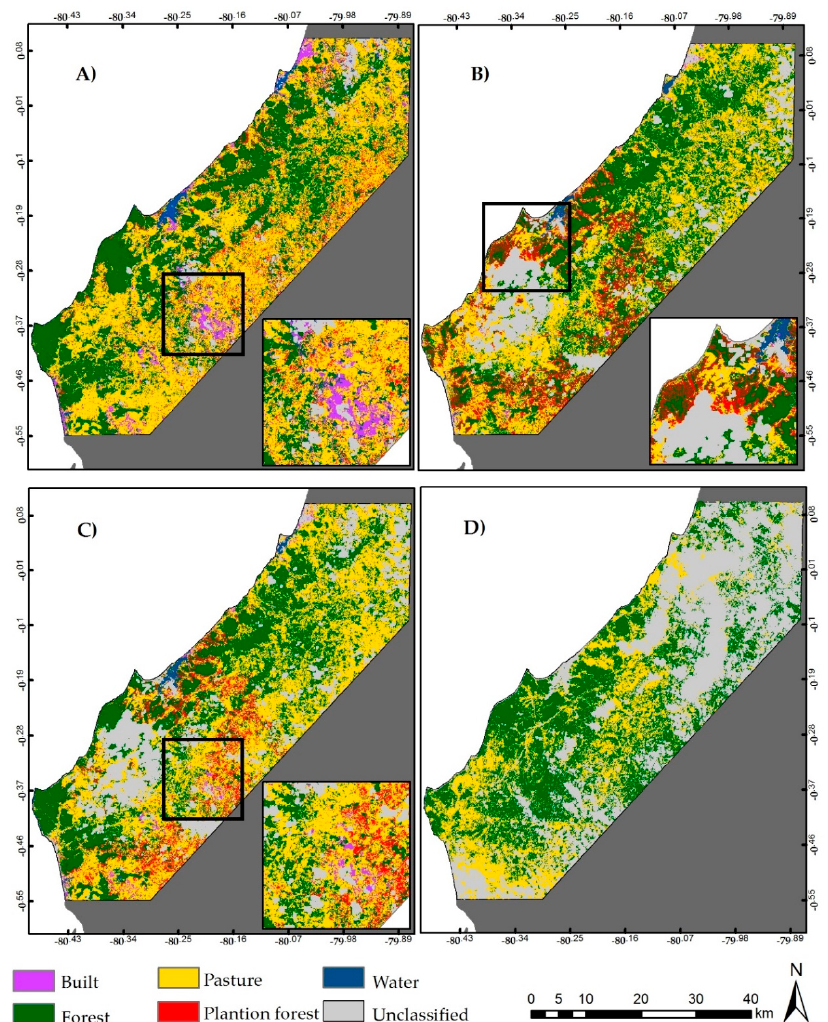
Figure 3. Random Forests (RF) land cover classification maps. ( A ) RF using predictor variables from the dry season. ( B ) RF using predictor variables from the wet season. ( C ) RF using predictor variables from the dry and wet seasons. ( D ) 1990 RF classification. Inset maps show locations of important transitions discussed in the text.